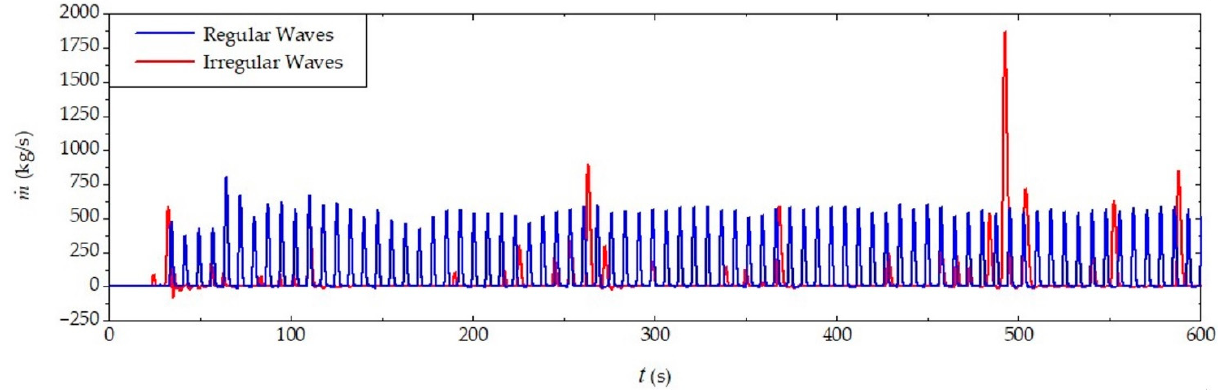
Figure 14. Mass flow rate entering the reservoir due to the incidence of the representative regular waves and realistic irregular waves for SVP.